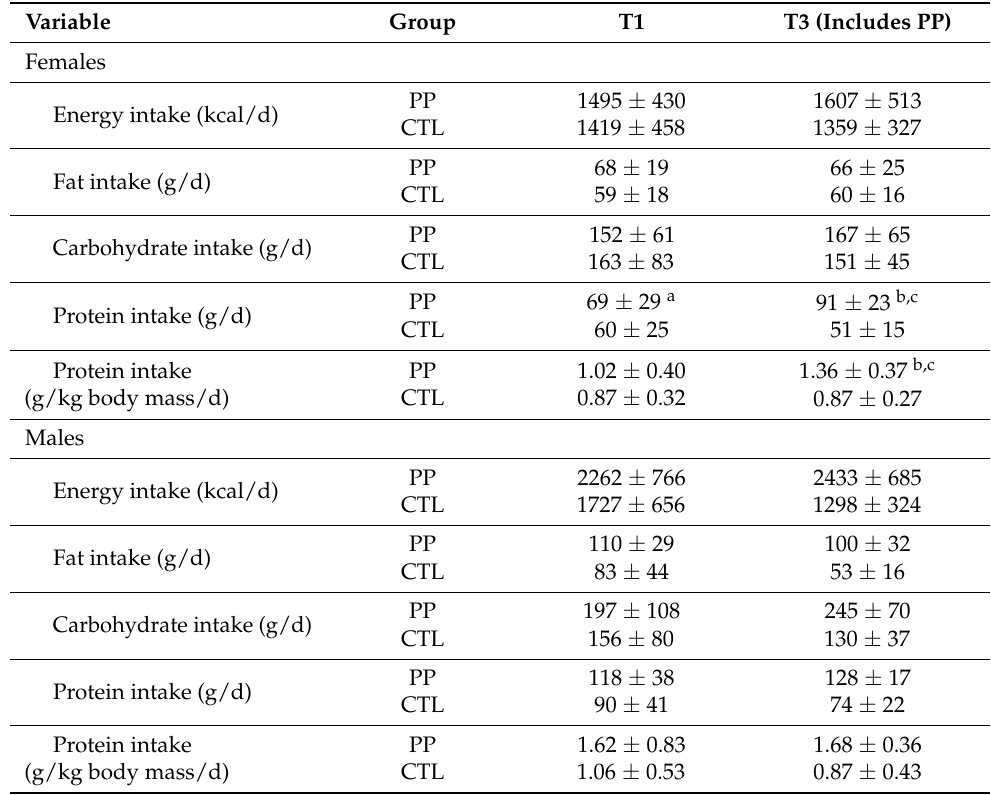
Table 3. Self-reported food log